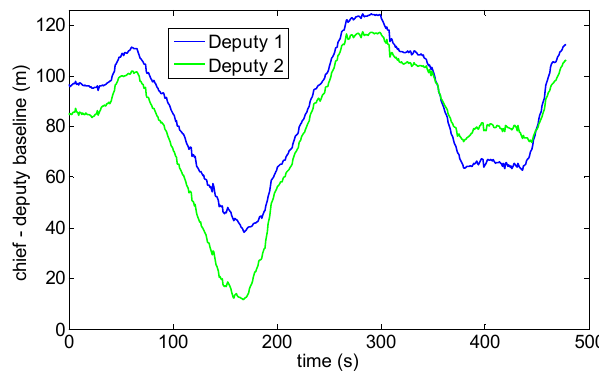
Figure 12. Chief-deputies baselines Test 2.